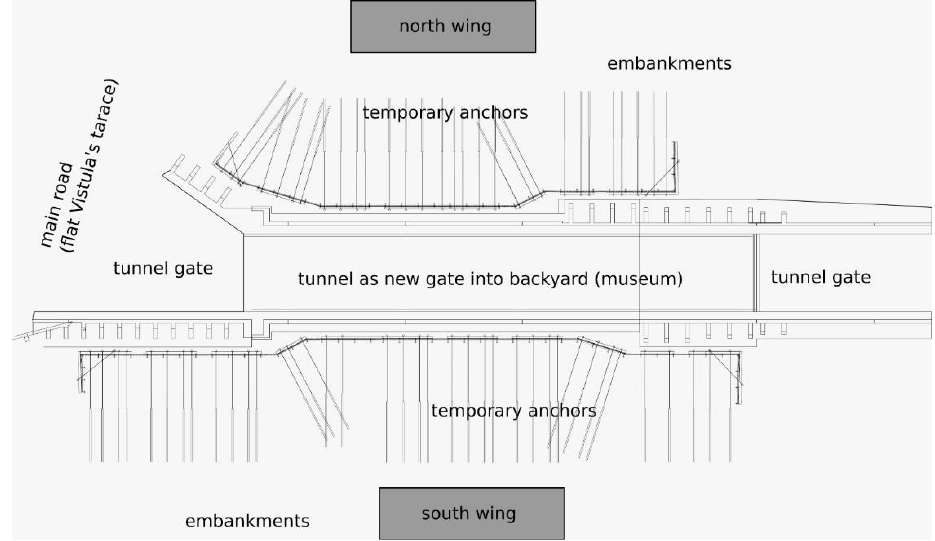
Figure 3. The designed entry to the Citadel with the protection of the excavation in the anthropogenic soils (anchored soldier pile wall).